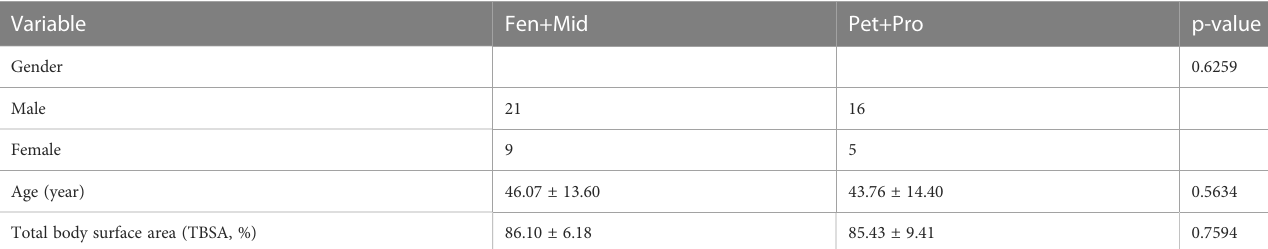
TABLE 1 General information of